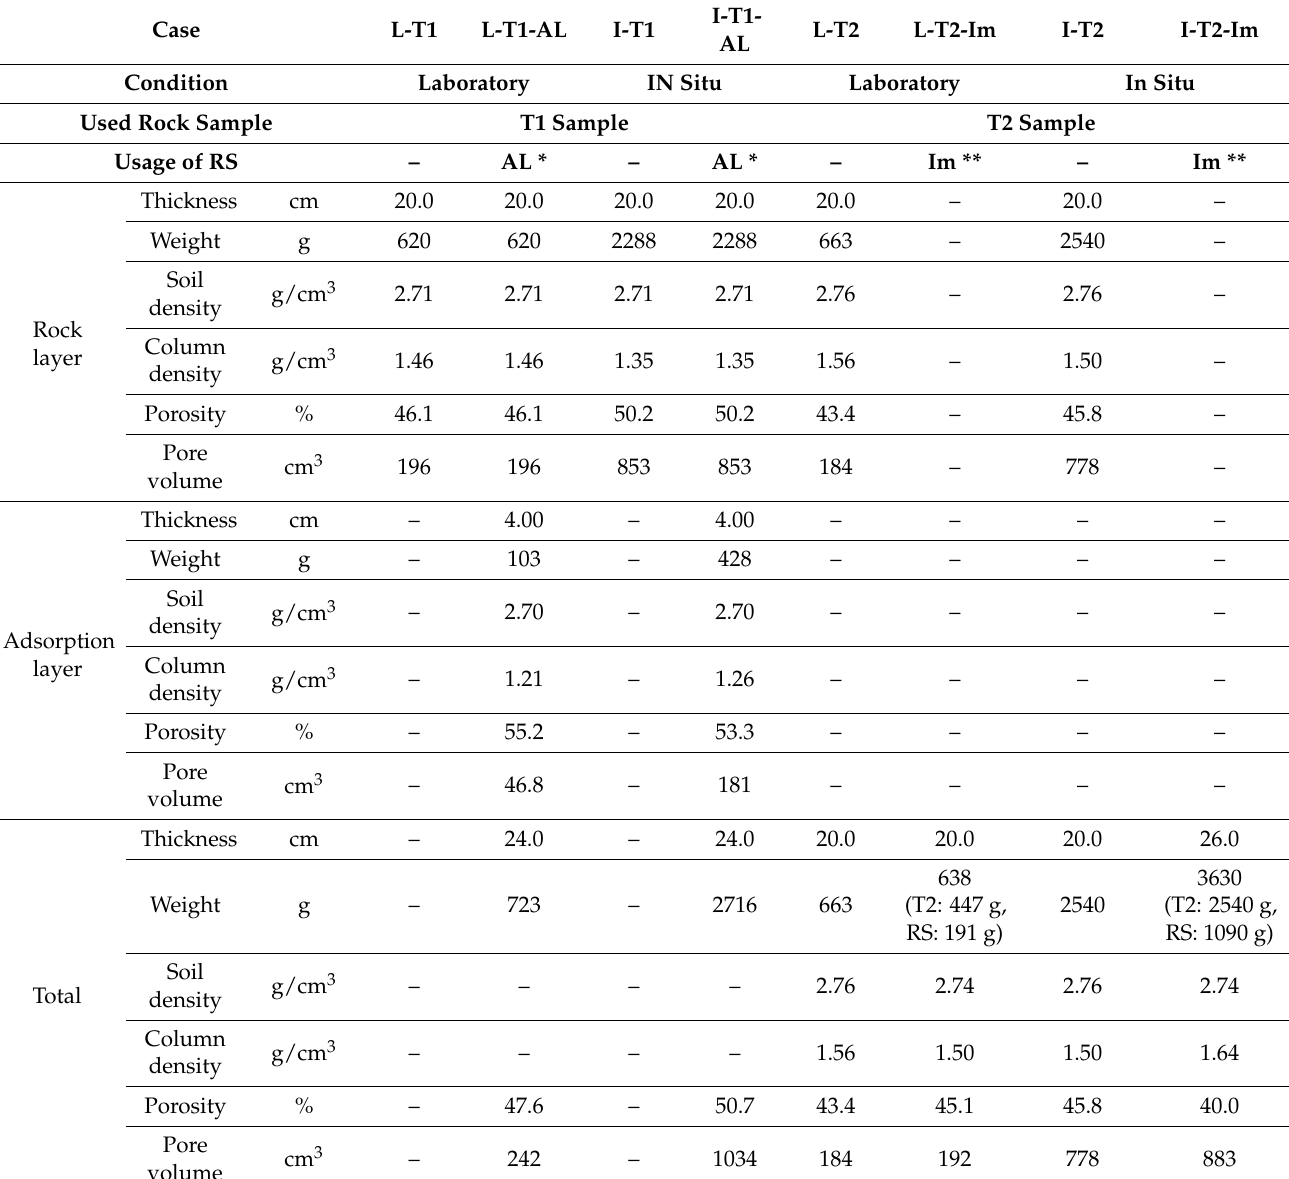
Table 1. List of laboratory and in situ column experimental